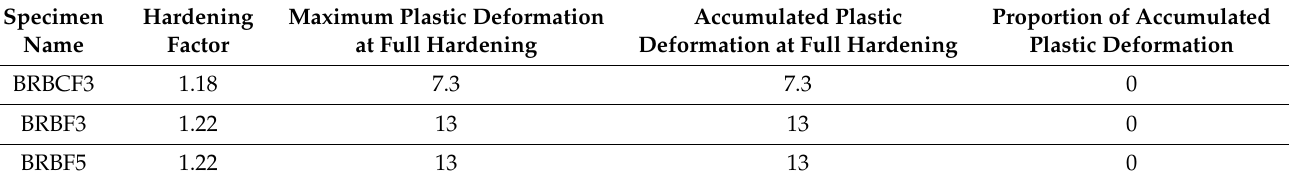
Table 6. Input BRB hardening parameters.